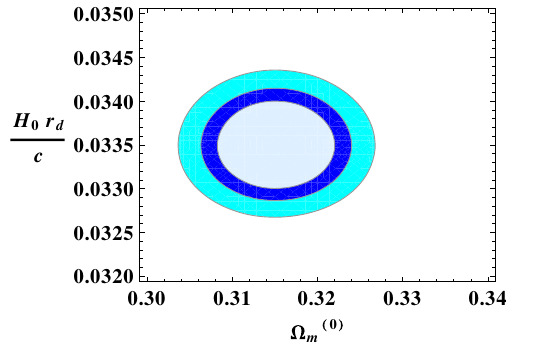
Fig. 8 Observational constraints on the parameters space ( (cid:13) ( 0 ) m − H 0 r d / c ) at the 68.3% (light blue), 90% (dark blue) and 99% (cyan) confidence levels